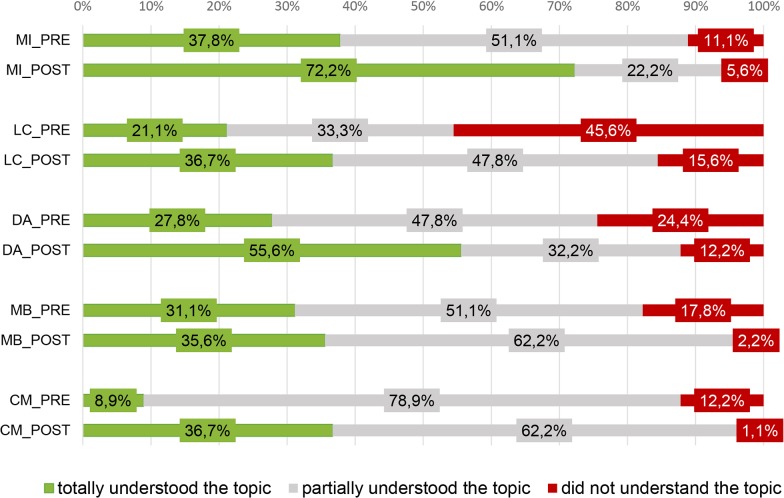
Percentage of residents who have ‘understood’,
‘partially understood’ or ‘not understood’ each
studied topic.For Figure simplification, topics were abbreviated to their name initials:
Medical Importance (MI), Local Context (LC), Domestic Attribute (DA),
Mosquito Breeding (MB), Control Measures (CM) ‘PRE’
and ‘POST’ represents PRE-outbreak study and POST-outbreak
study.